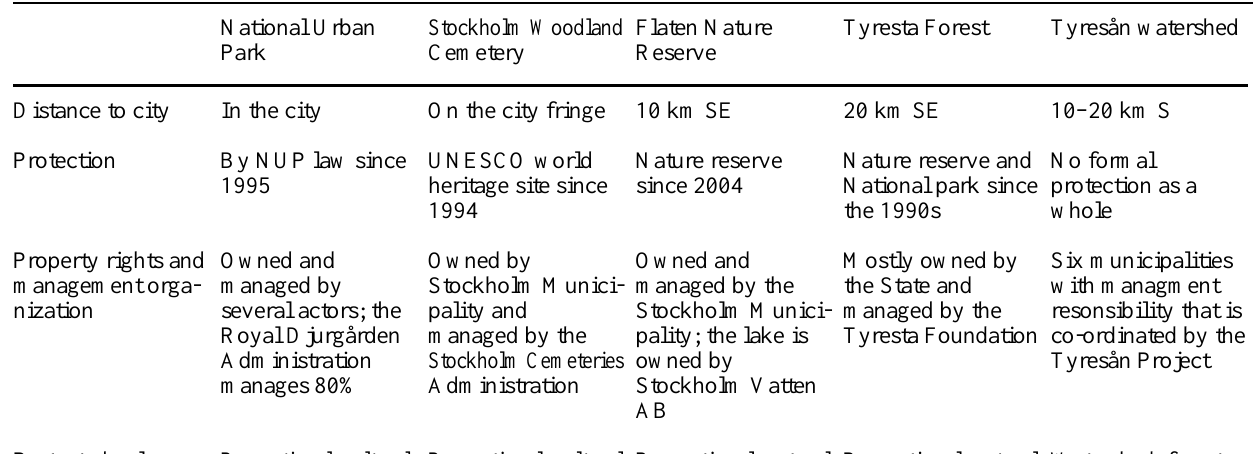
Table 2. Description of the five studied green spaces. For an in-depth description, see Appends. 1–3 and Borgström